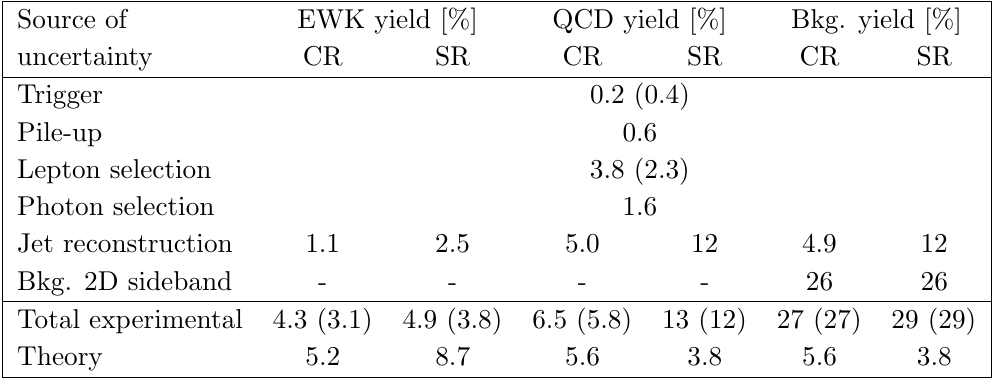
Table 2 . Summary of the dominant experimental systematic uncertainties in the event yield in the CR and SR, for the electron (muon when di(cid:11)erent) channel and for the signal and main background